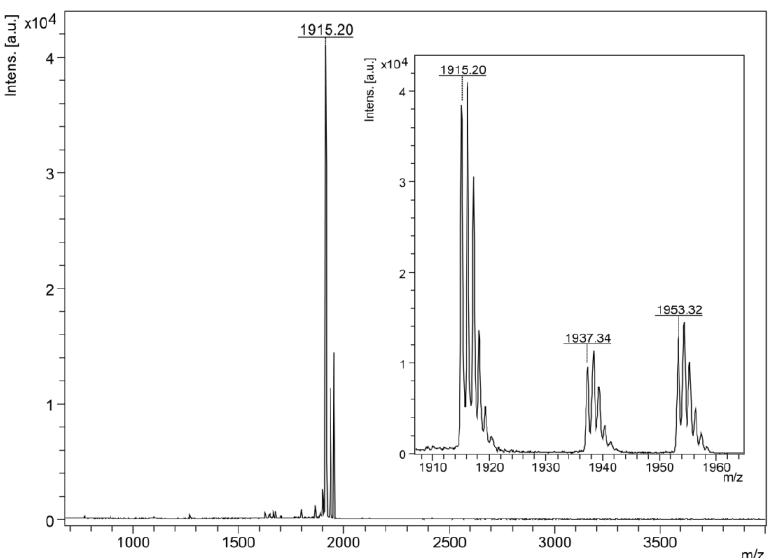
Figure 2. MALDI-TOF mass spectrum of the antibacterial peptide (isolated from Br24 fraction). In the insert is shown the presence of sodium (+22 Da) and potassium (+38 Da) adducts.